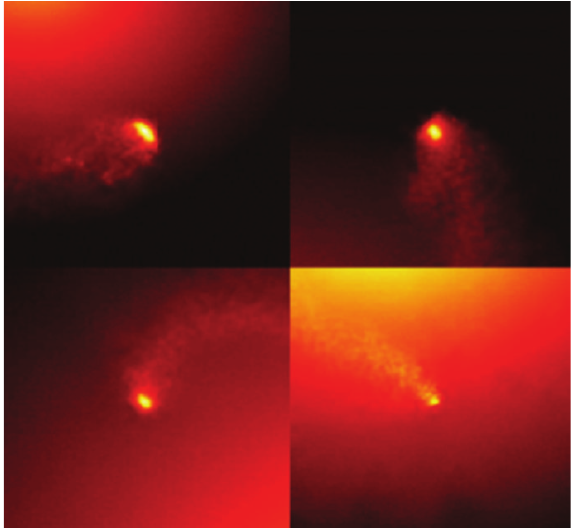
Figure 6: Evolution of the gas-dominated disky dwarf model studied in Mayer et al. [41], which produces a dark-matter-dominated dwarf resembling Draco after 10 Gyr of evolution. This N-Body + SPH simulation employed millions of dark matter, gas, and star particles. It included tidal mass loss due to a live Milky Way halo, ram-pressure stripping in a tenuous gaseous halo, radiative cooling, and a time-varying cosmic ionizing UV background consistent with the Haardt and Madau (2000) model. The snapshots show the color-coded logarithmic density maps (the brighter the color, the higher will be the density, with densities in the range 10 − 32 − 10 − 23 g cm − 3 ) for the first 2.5 Gyr of evolution. Boxes are 30 kpc on a side. The dwarf begins falling into the Milky Way halo on a typical eccentric cosmological orbit (apo/per = 5 at the beginning of the simulation, which corresponds to z = 2). At the first pericenter passage ( R peri = 30kpc) a prominent ram-pressure tail is evident (top left), and once the dwarf comes to first apocenter (top right), it has lost already more than half of its gas. As it begins the second orbit, ram-pressure stripping continues to remove gas (bottom left), until all gas is stripped at second pericenter (bottom